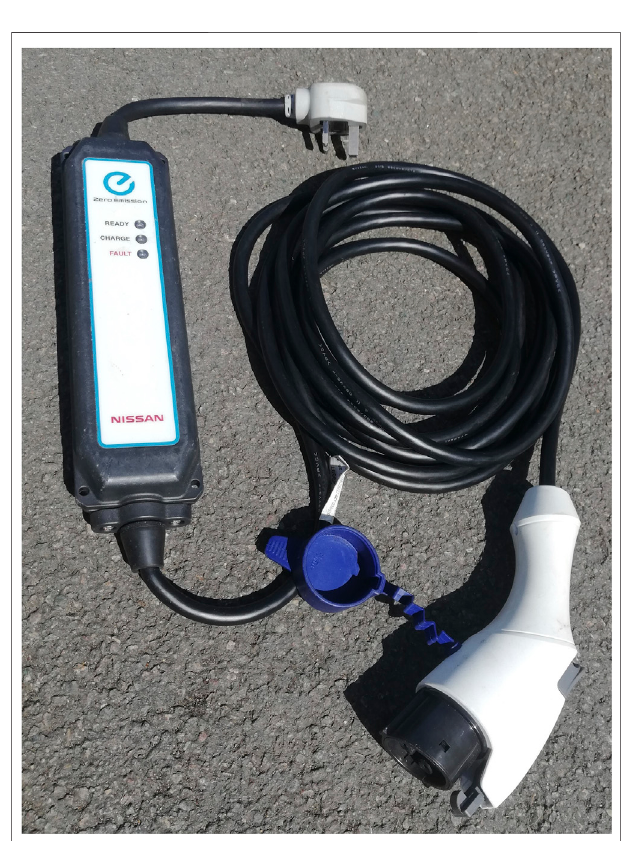
FIGURE 3 | This Mode 2 cable has a protection device that allows an EV to be safely charged from a standard 13 Amp socket